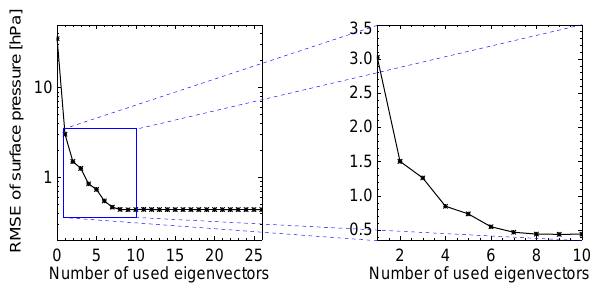
Fig. 7. Global root mean square error of surface pressure, derived Figure 7: Global root mean square error of surface pressure, derived from approx- from approximated transmittance, as a function of the number of imated transmittance, as a function of the number of eigenvectors used. eigenvectors